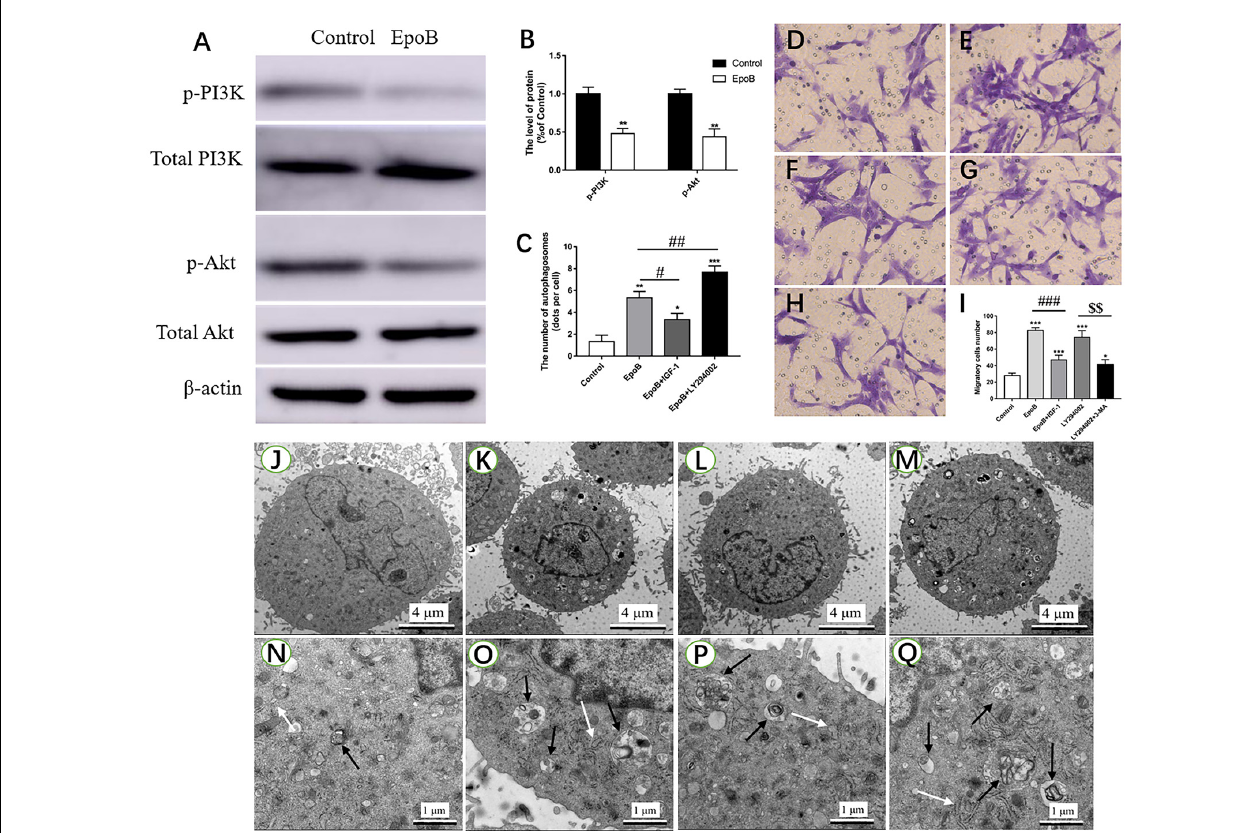
FIGURE 7 | EpoB significantly enhances migration by PI3K/Akt signaling-mediated autophagy in SCs. Representative western blotting (A) and data analysis of p-PI3K and p-Akt in each group (B) . (C) Quantification of the total number of autophagosomes in each group. Transwell analysis of migratory cells in the control (D) , EpoB (E) , EpoB+IGF-1 (F) , LY294002 (G) , and LY294002+3-MA (H) groups at 24 h after treatment. (I) Quantification of the total number of migratory cells in each group. TEM analysis showing the formation of autophagosomes in SCs from the control (J,N) , EpoB (K,O) , EpoB+IGF-1 (L,P) , and EpoB+ LY294002 (M,Q) groups at 24 h after treatment. White arrowheads indicate normal endoplasmic reticula; black arrowheads indicate double-membraned autophagosomes. Scale bars: (J–M) 4 µ m; (N–Q) 1 µ m. * P < 0.05, ** P < 0.01, and *** P < 0.001 compared to the control group; # P < 0.05, ## P < 0.01, and ### P < 0.001 compared to the EpoB group, $$ P < 0.01 compared to the LY294002 group. Abbreviations: EpoB, epothilone B; 3-MA, 3-methyladenine; SCs, Schwann cells; TEM, transmission electron